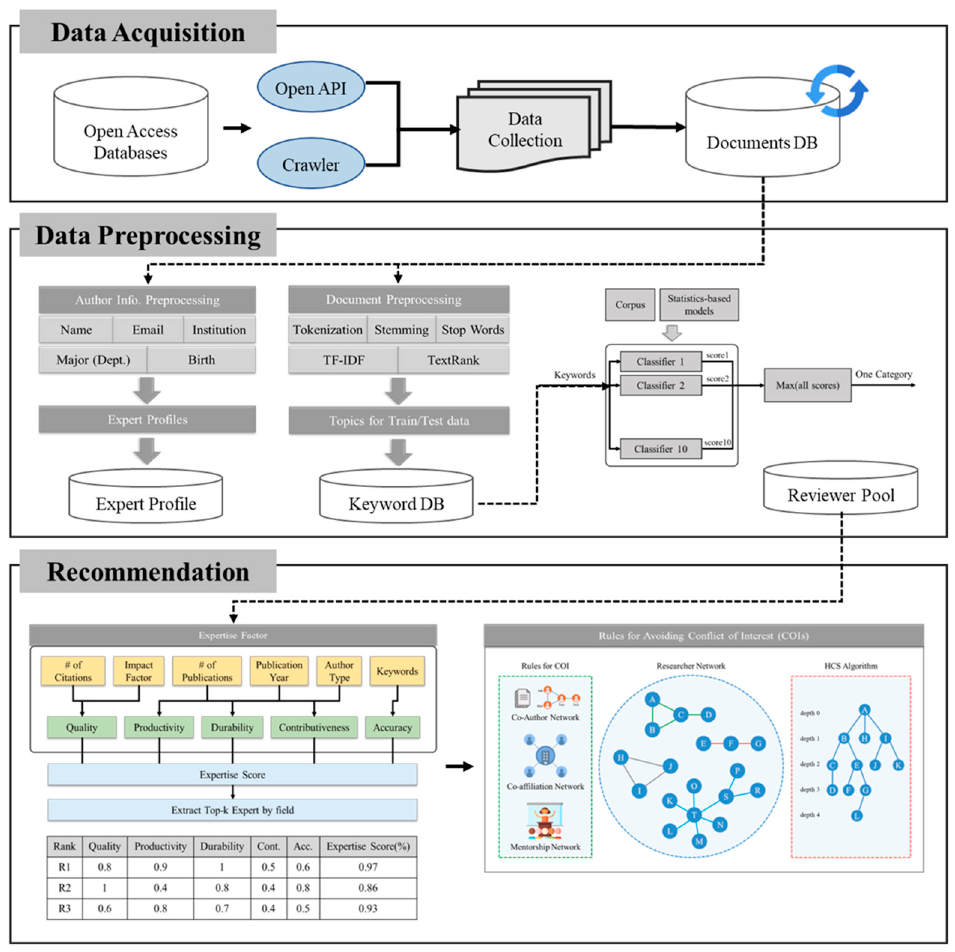
Figure 1. Framework of the Top-K reviewer recommendation system without CoI.